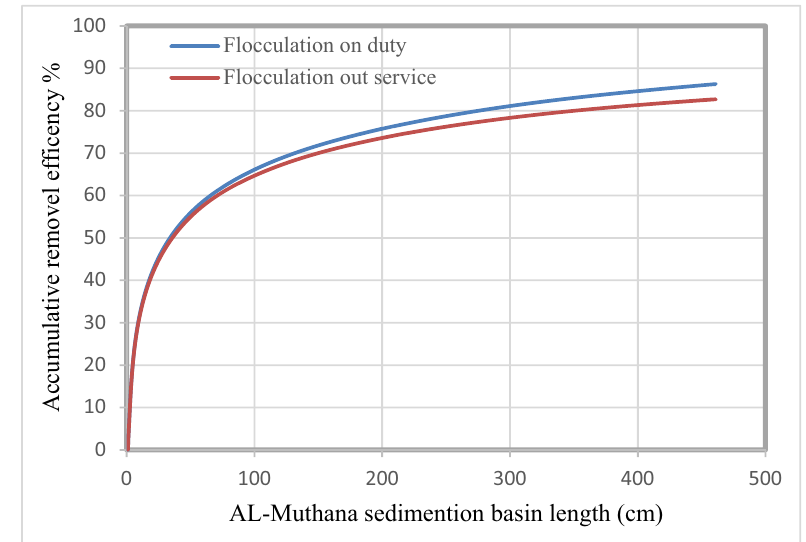
Figure 8: Di ff erence in accumulative removal e ffi ciency between fi rst and second